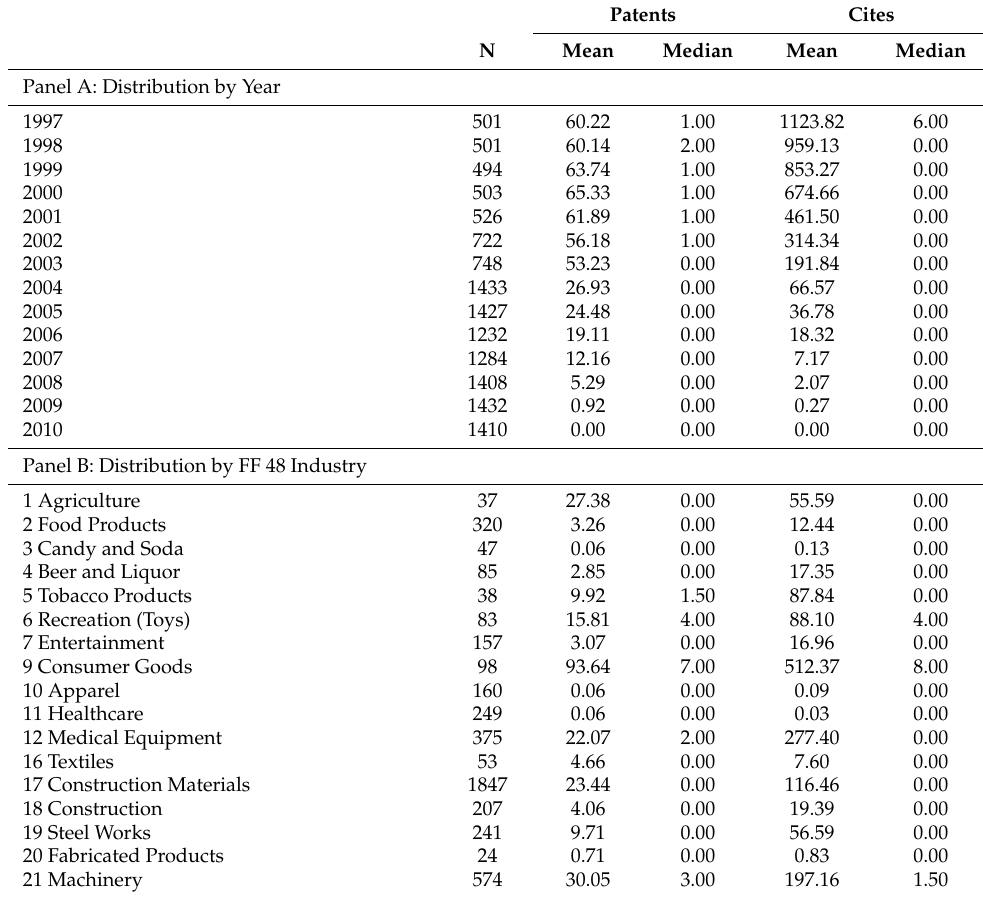
Table 2. Sample Distribution of Innovation Variables by Year and Industry. This table provides sample distribution of innovation variables by year (Panel A) and Fama–French 48 industry (Panel B). All except binary variables are winsorized at the upper and lower 1% level. Variables are defined in the Appendix